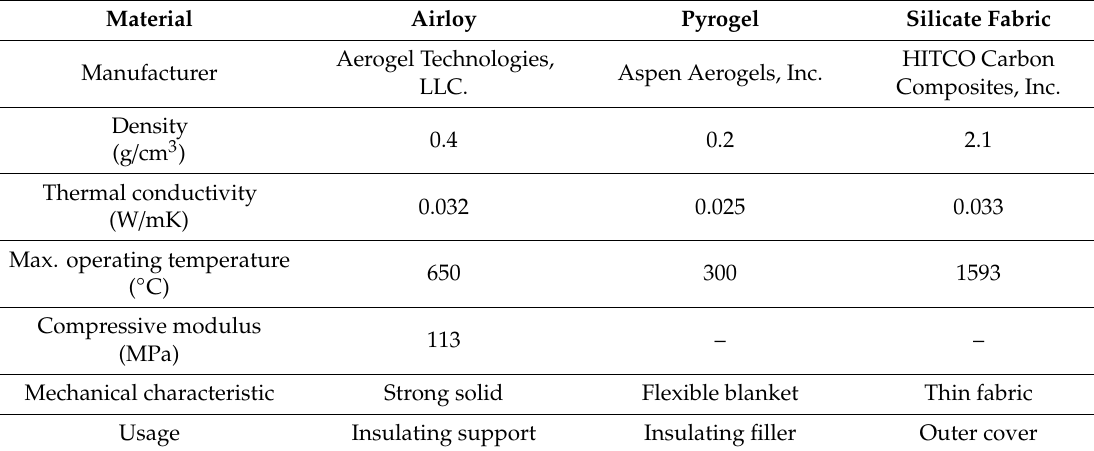
Table 2. Brief properties and characteristics of materials chosen for heat